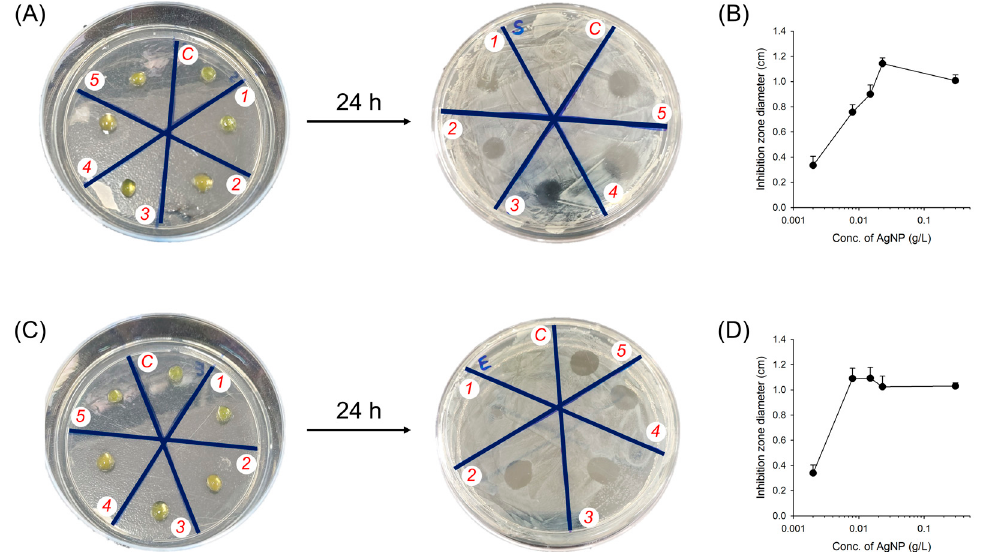
Figure 7. Bactericidal activity of AgNP-incorporated GelMA hydrogels. Representative images of bacterial colonies formed by ( A ) S. aureus and ( C ) E. coli with the AgNP-incorporated hydrogels were placed on the agar petri dish for a day to analyze the inhibition zone. C = control, AgNP-free hydrogels. Areas 1–5 = AgNP-incorporated hydrogels at concentrations of 2, 8, 15, 23, and 30 mg L − 1 AgNPs, respectively. Quantitative inhibition zone area of bacterial colonies formed by ( B ) S. aureus and ( D ) E. coli with the AgNP-incorporated hydrogels ( n = 3).